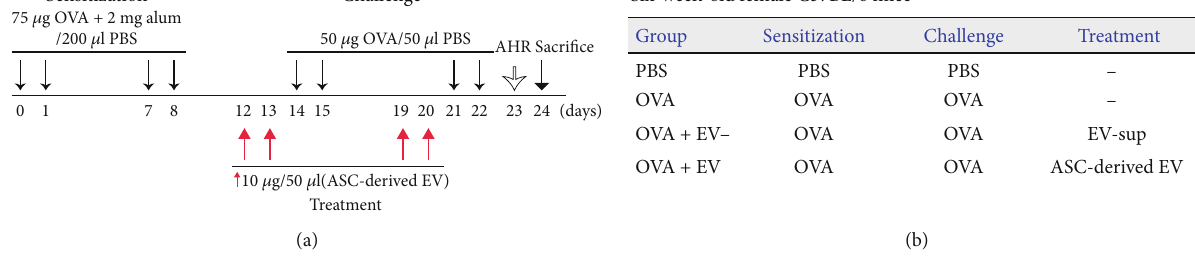
Figure 1: The experimental protocol. (a) Mice were sensitized on days 0, 1, 7, and 8 by intraperitoneal injection of ovalbumin (OVA) and then challenged intranasally with OVA on days 14, 15, 21, and 22. On days 12, 13, 19, and 20, 10 μ g/50 μ l of the adipose stem cell- (ASC-) derived extracellular vesicles (EVs) was administered intranasally. (b) Mice were divided into 4 groups according to di ff erent sensitization, challenge, and pretreatment